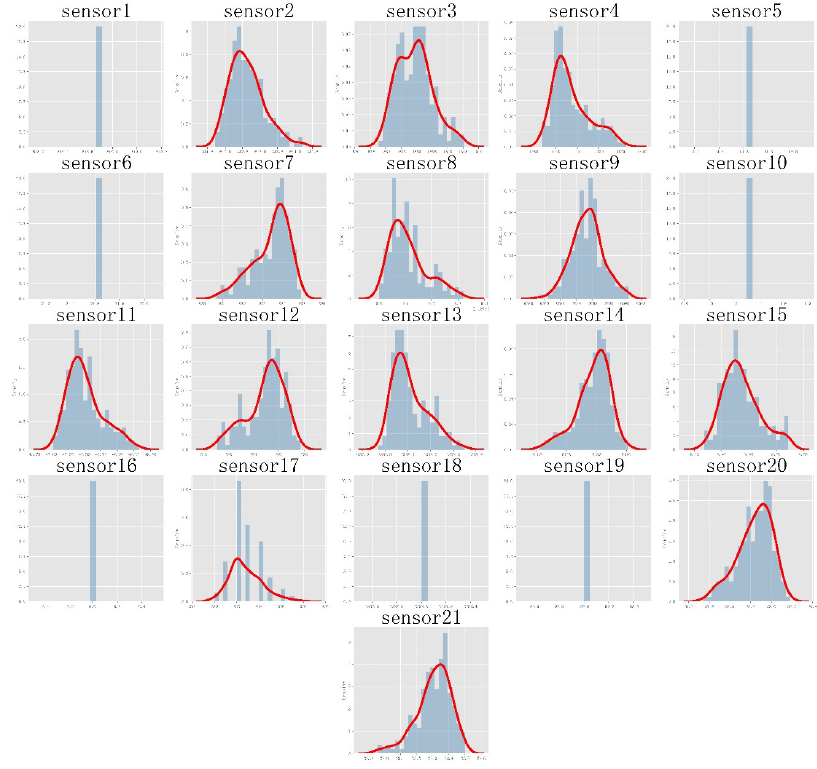
Figure 6. Time series distribution diagram of 21 sensors’ data of the aeroengine.